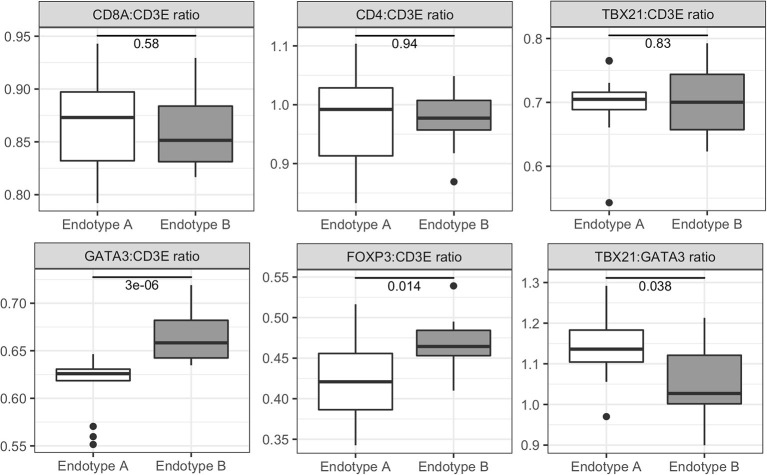
Expression ratios of T cell related genes for pediatric vasculitis Endotypes A and B. Relative abundance and ratios (y-axis) of the expression of genes for T cell markers in Endotype A and Endotype B patients (x-axis). T cell marker genes included CD3E (present in all T cells), CD8A (CD8+ cells), CD4 (CD4+ cells), TBX21 (Th1 cells), GATA3 (Th2 cells), FOXP3 (Tregs), and RORC (Th17 cells). Gene expression ratios were calculated from variance stabilized counts. Significance of the ratio between the clusters is reported within each boxplot and was determined by the Wilcoxon Rank Sum test. Additional data shown in Supplementary Figure 3.